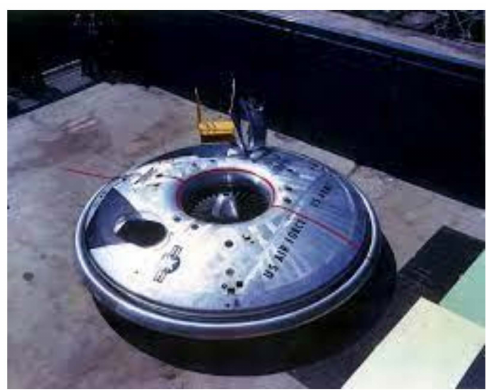
Figure 5. Avro Canada VZ-9 Avrocar [24].